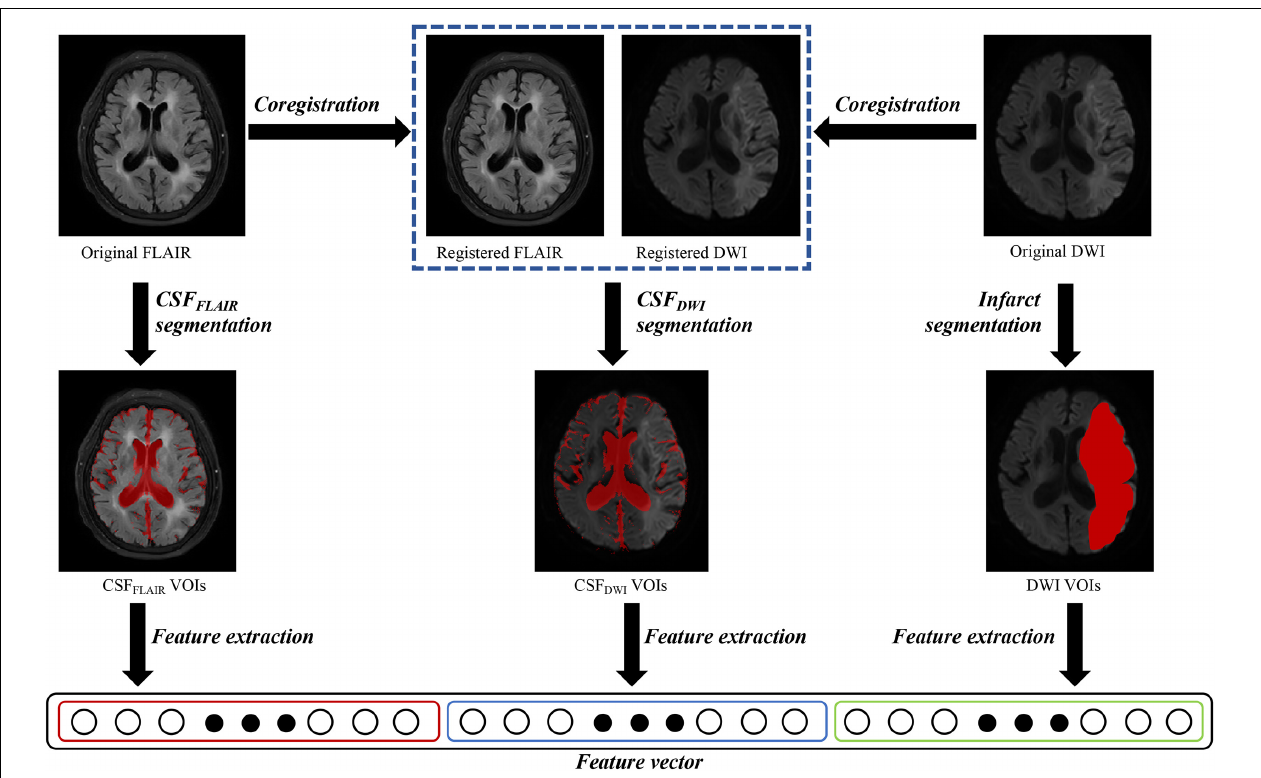
FIGURE 2 | Overview of image processing with diffusion weighted imaging (DWI) and fluid attenuated inversion recovery (FLAIR) images for each patient. Infarct regions were segmented on the DWI images, and the cerebrospinal fluid regions were segmented on the FLAIR images (CSF FLAIR ). The FLAIR images were overlaid onto the DWI images, and the cerebrospinal fluid regions on DWI images (CSF DWI ) were segmented on the registered DWI images. One thousand three hundred and sixteen features were extracted from DWI volumes of interest (VOIs), CSF FLAIR VOIs and CSF DWI VOIs,